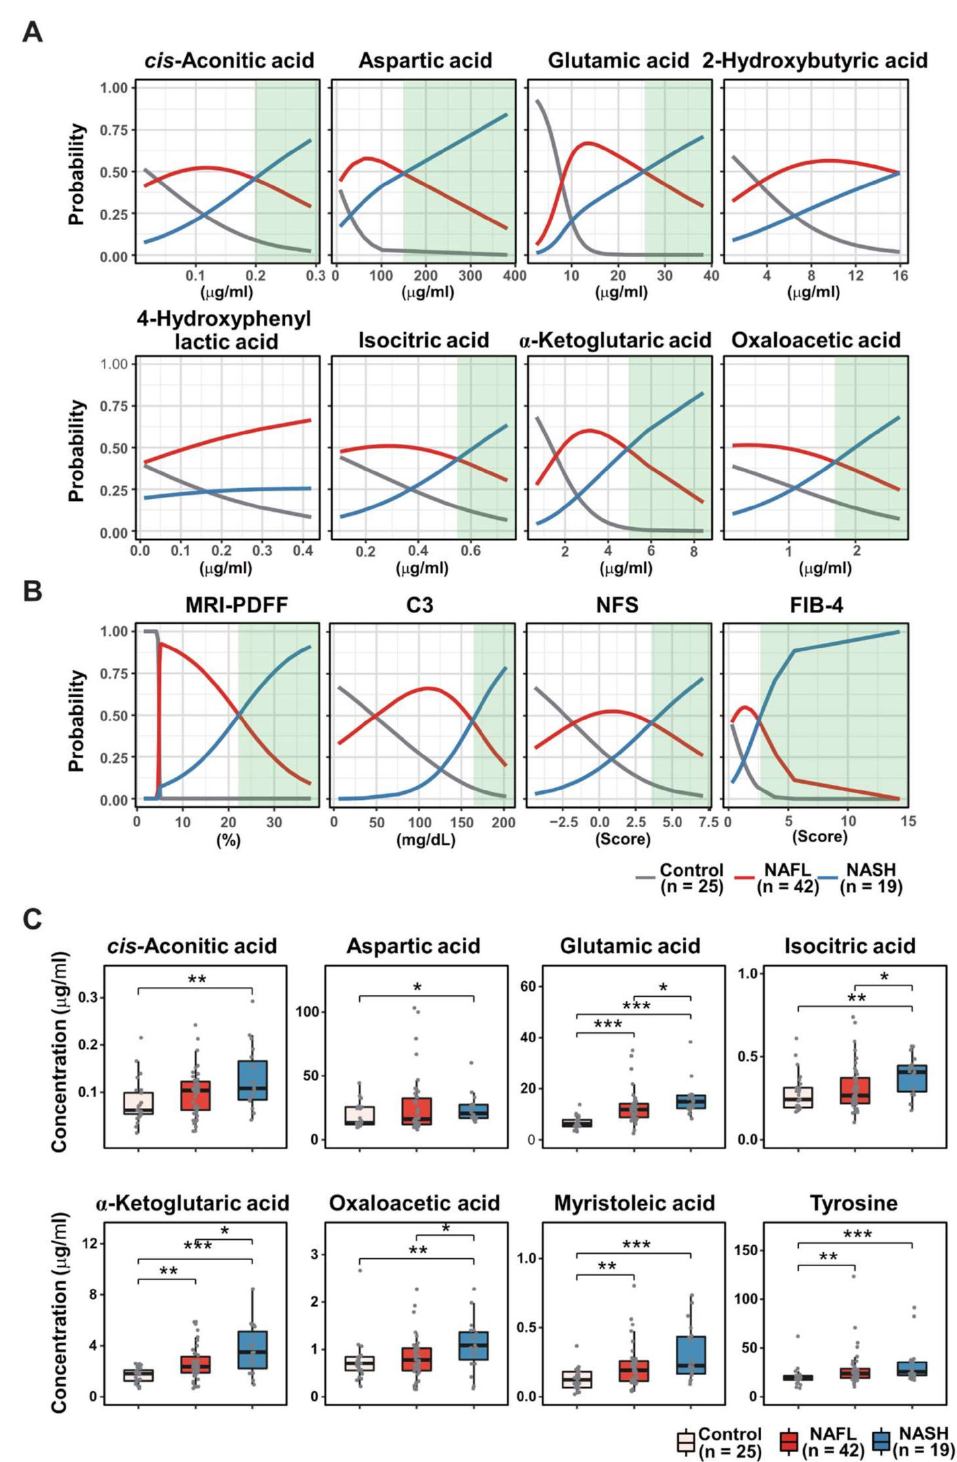
Figure 4. Multinomial logistic regression (MLR) estimating the performance of RF-featured metabo- lites and clinical parameters, including MRD-PDFF, C3, NFS, and FIB-4 in the discrimination of the three groups. MLR curves showing the probability of eight RF-featured metabolites ( A ) and of clinical parameters ( B ) discriminating NASH vs. NAFL. Green windows indicate the zone distinguishing NASH from non-NASH. ( C ) Boxplots showing the abundance of eight MRL-selected metabolites in the control, NAFL, and NASH groups. Significance was evaluated by the Kruskal-Wallis test. ***, p < 0.001; **, p < 0.01; *, p <